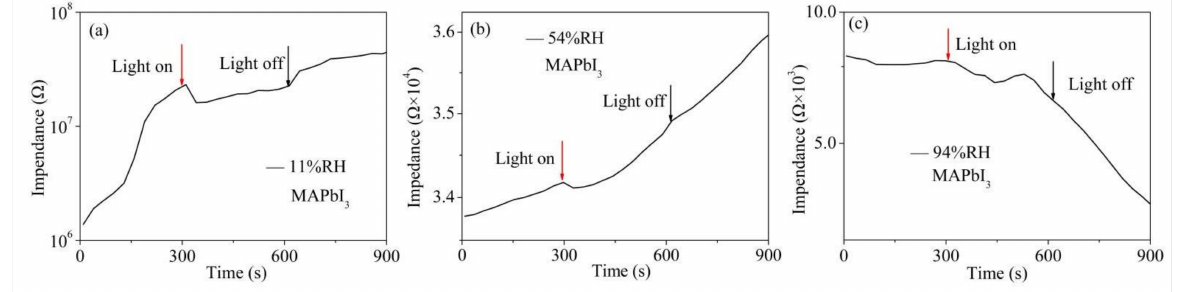
Figure 8. Illumination-induced impedance variations of the MAPbI 3 -based sensor in the environment of ( a ) 11%, ( b ) 54%, and ( c )